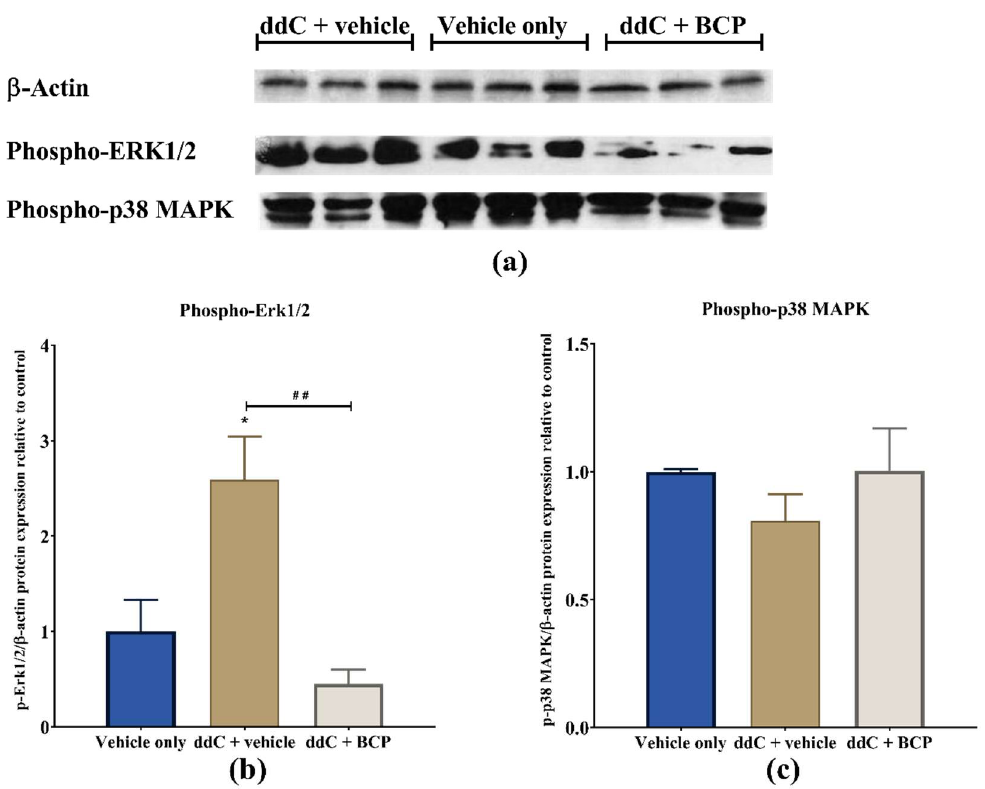
Figure 6. Effect of treatment with 2′-3′-dideoxycytidine (ddC) or coadministration of ddC with β-caryophyllene (BCP) on the levels of phosphorylated p44/42 MAPK (phospho-extracellular-signal-regulated kinases 1 and 2, p-Erk1/2), and phosphorylated p38 mitogen-activated protein kinases (p-p38 MAPK) in the brains of female BALB/c mice at day 7 post-first-injection (dpi) of ddC. ( a ) X-ray images of the blots; ( b ) relative expression of p-Erk1/2; ( c ) relative expression of p-p38 MAPK. Their expression profile was normalized to β-actin and the control group. The bars represent the mean ± SEM of values obtained from three animals. * p < 0.05 compared to vehicle-only-treated control mice, and ## p < 0.01 compared to mice treated with ddC + vehicle (one-way ANOVA was followed by Tukey’s multiple comparisons test).